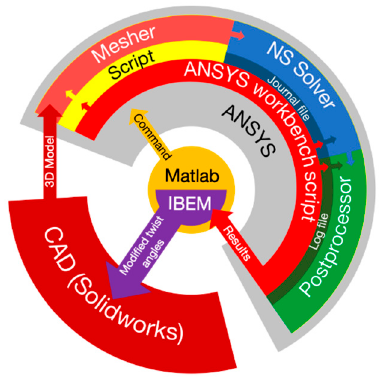
Figure 2. Schematic representation of the automation framework.